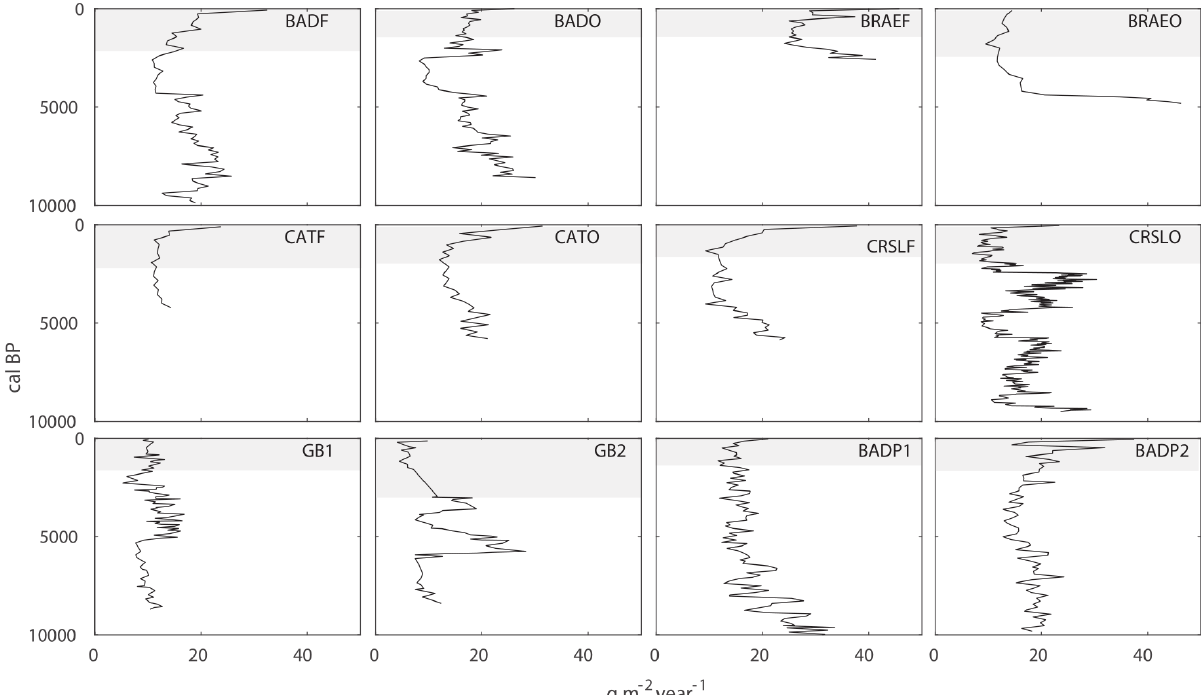
Figure 2. New and re-analysed records of carbon accumulation for the Flow Country. Area shaded in grey represents the upper 50 cm of the core and the transition to acrotelm peat. CRSLO, CATO and BADO have been previously published in Ratcliffe et al .